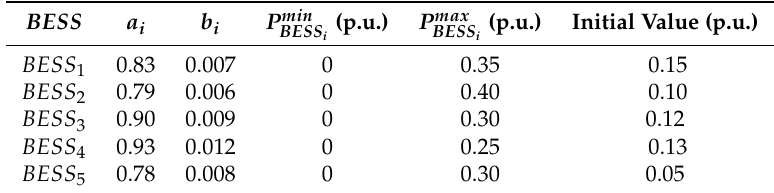
Table 1. Simulation parameters of BESS.